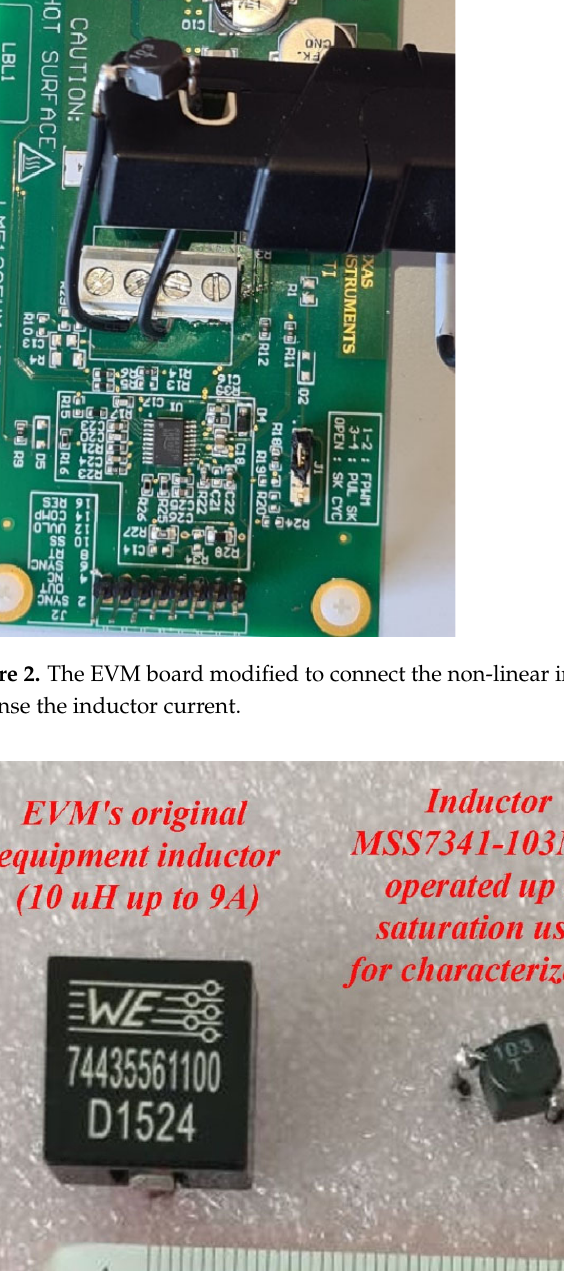
Figure 3. Comparison of the original inductor equipped on the EVM (left side) with the one applied in this paper (right side). 3.2. The Inductor under Test The MSS7341 ‐ 103MLD inductor belongs to “shielded mount power inductor” series. It is a general ‐ purpose ferrite inductor characterized by a low DC resistance and excellent current handling. Its rated value is 10 μ H with 20% tolerance. The manufacturer provides the DCR resistance value (max 0.038 Ω ) and the current, causing 10%, 20% and 30% drop of the inductance (Figure 4). These values allow a rough estimation of the value at which the inductance is halved, meaning the saturation. Considering the rated value of 10 μ H, it is halved at about 2.35 A. It should be remarked that the DC current causing the induct ‐ ance drop is given at 25 °C and that the fitted curve loses its accuracy increasing current after the saturation value. A dedicated experimental characterization will allow identify ‐ ing more precisely the inductor behavior, as explained in the following.